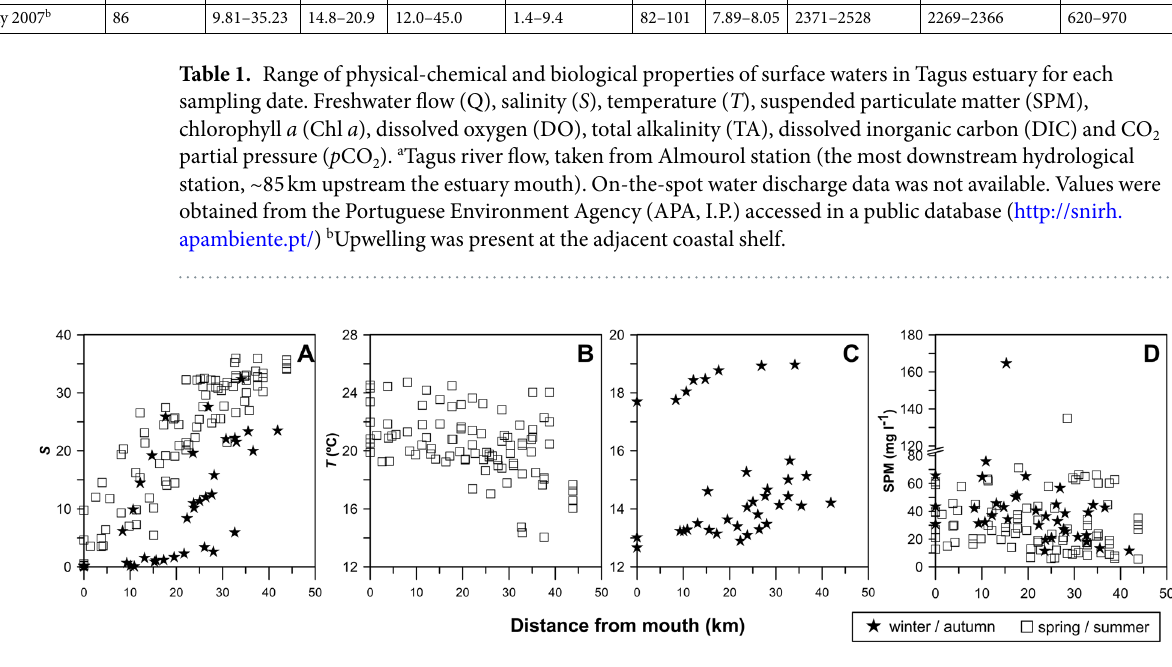
(Table 1). p CO 2 values were higher in the riverine section, reaching as high as 9160 µ atm in February 2004 (Fig. 4D; Table 1), a value ~24 times higher than p CO 2 of atmospheric equilibrium (383.9 µ atm). Seasonally average values of p CO 2 remain rather stabilized from winter to spring/summer and increased in autumn (Fig. 3G). Values of p CO